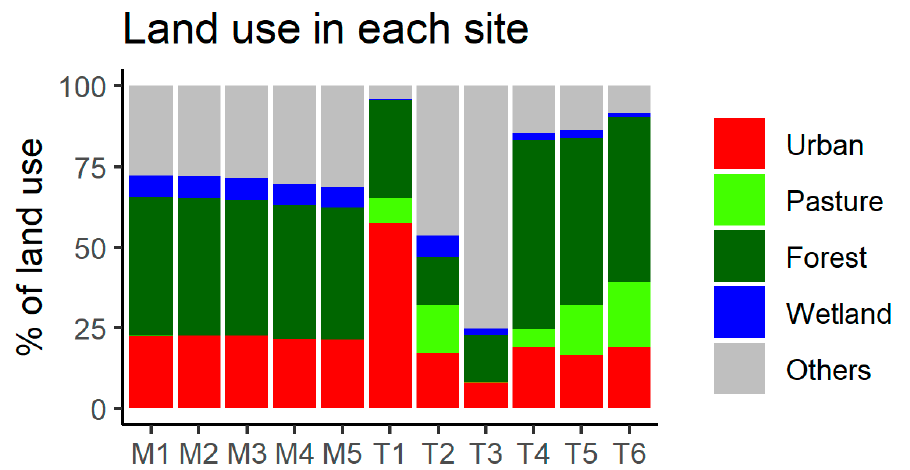
Figure 3. Percentage of each land use for each site in this study. Only the land use classifications used for the spatial stream network (SSN) models in this study are shown, including urban (red), pasture (light green), forest (dark green), and wetlands (blue). M indicates mainstem sites, whereas T indicates tributary sites of the sampling locations.